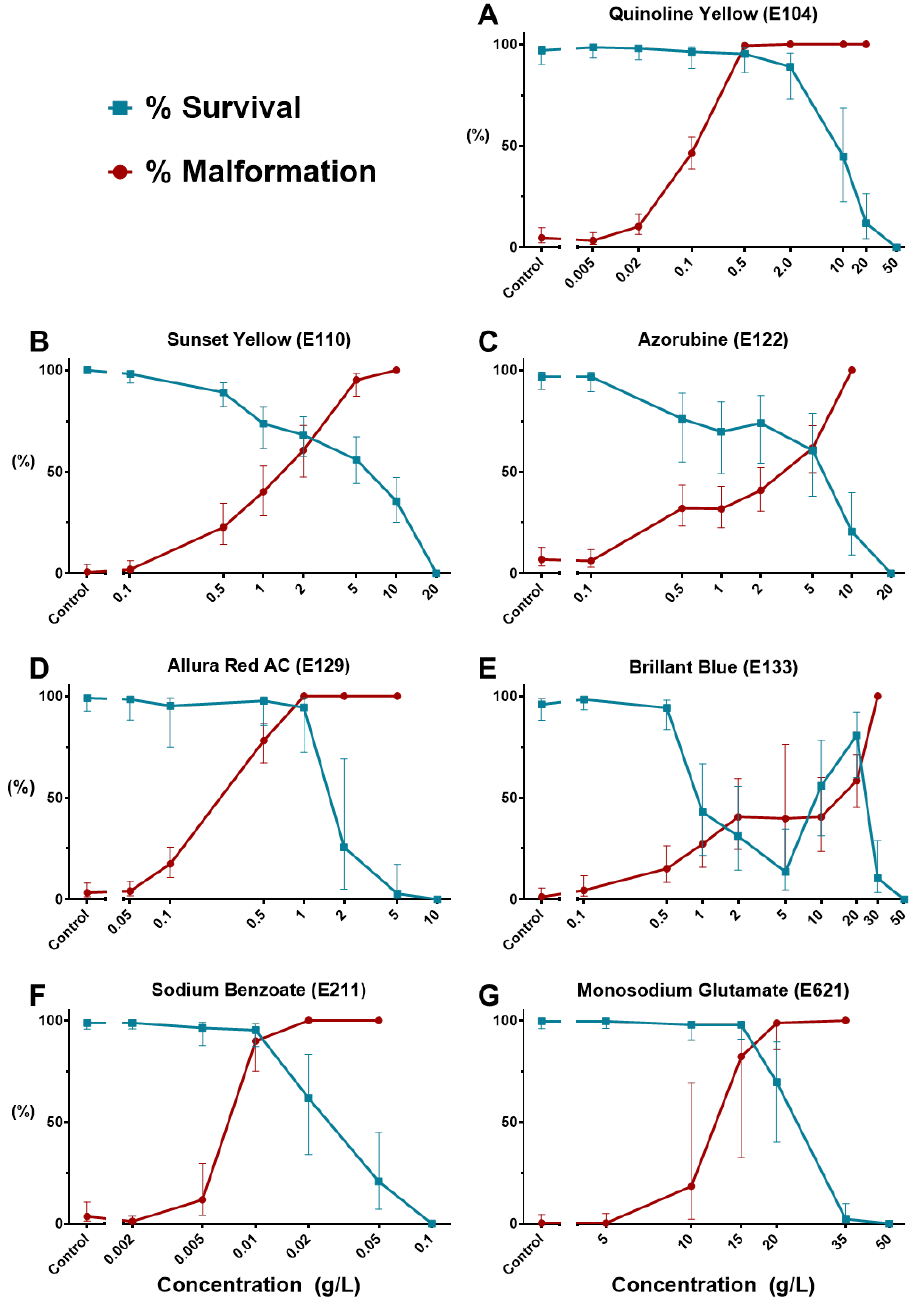
Figure 2. Dose–response curves showing embryonic survival (blue) and any malformation (red) upon 4-day treatment with different food additives. ( A ) Quinoline Yellow; ( B ) Sunset Yellow; ( C ) Azorubine; ( D ) Allura Red AC; ( E ) Brilliant Blue; ( F ) Sodium Benzoate; ( G ) Monosodium glutamate. Error bars showing 95% prediction intervals. Aspartame was excluded for not showing any observable